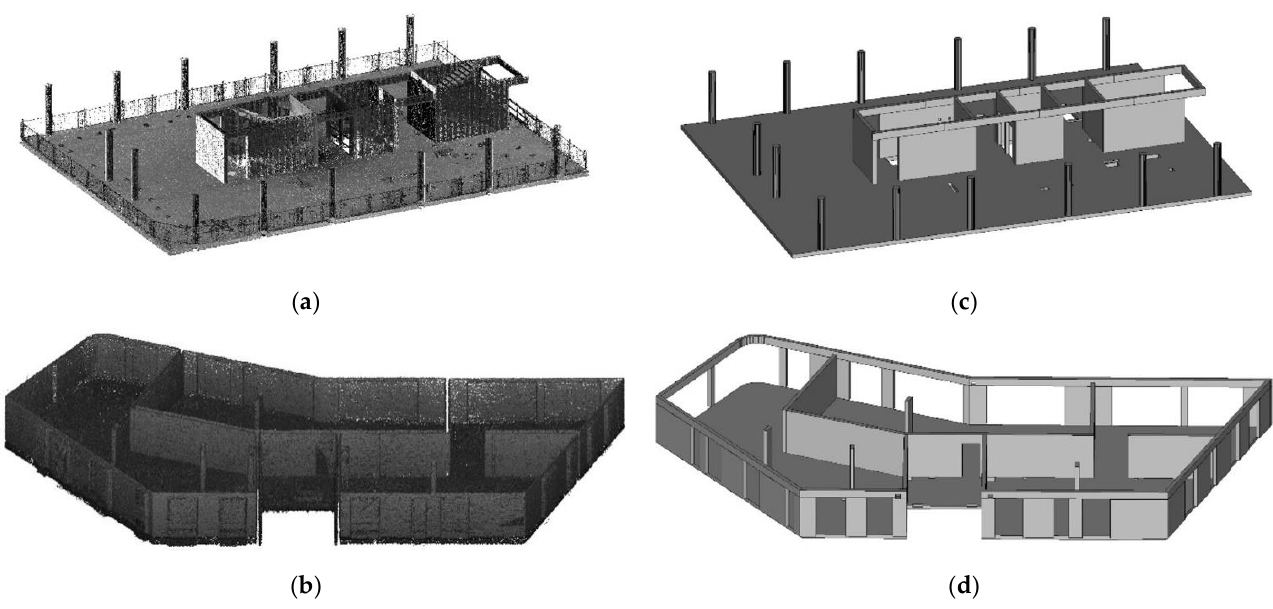
Figure 3. Main experimental data: ( a ) point cloud of the office building project SQVERAS; ( b ) point